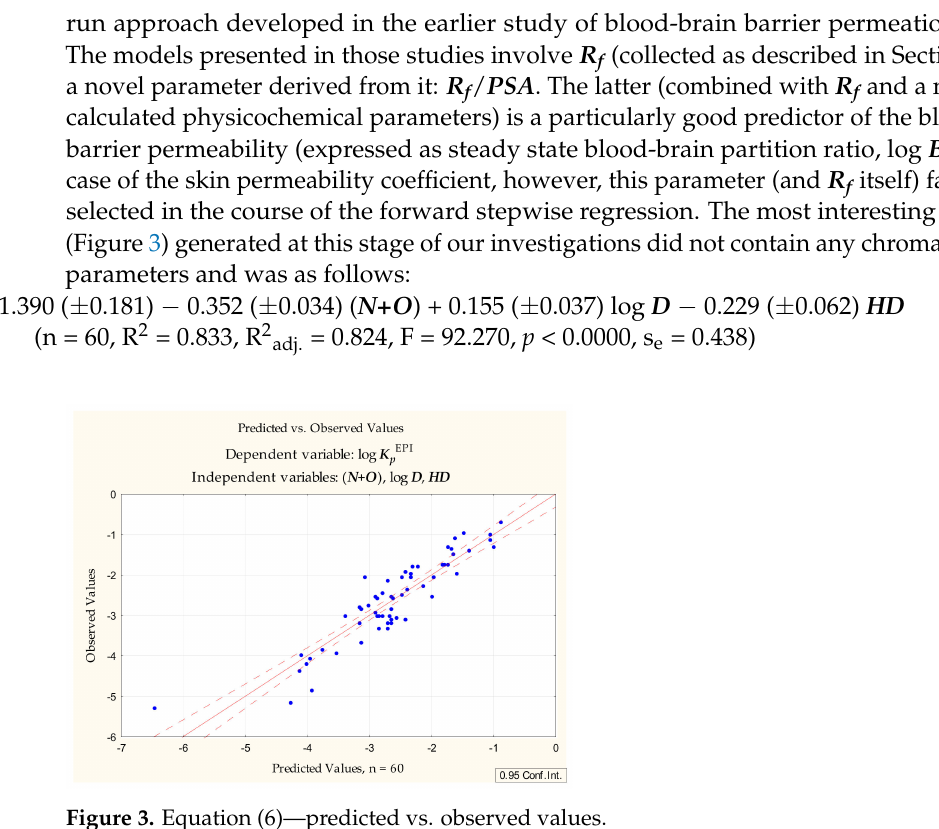
Figure 3. Equation (6)—predicted vs. observed